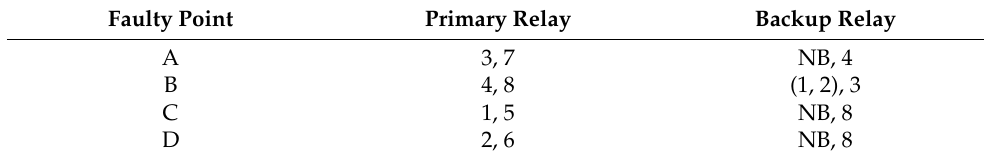
Figure 10. A single-ended multi-loop distribution power system (Case 3). Table 6. Relationships between primary and backup relays (Case 3).